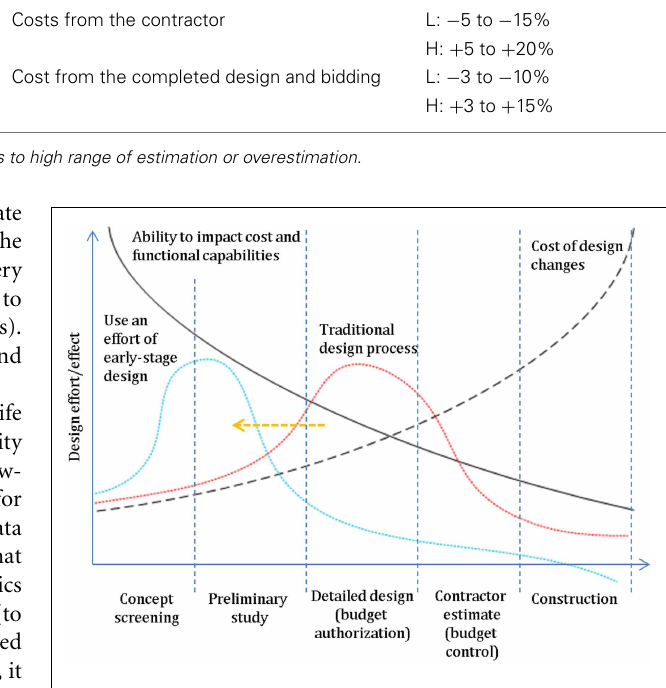
FIGURE 1 |The design effort and impact on the project development [adopted fromTowler and Sinnott (2013)]